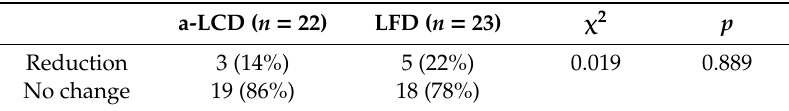
p value for comparison between treatments diets by Chi-square